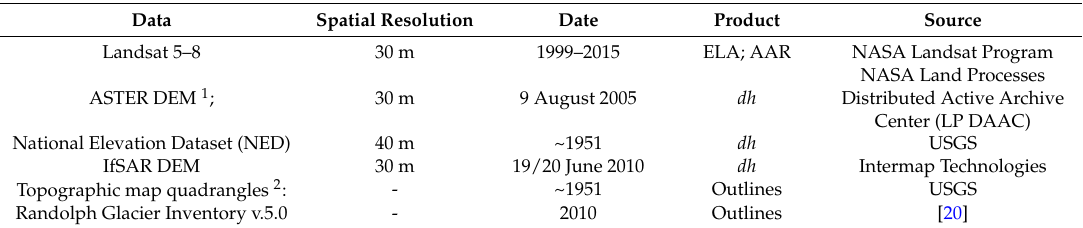
Table 1. Overview of geospatial data sets used in this study and derived products. dh denotes surface elevation